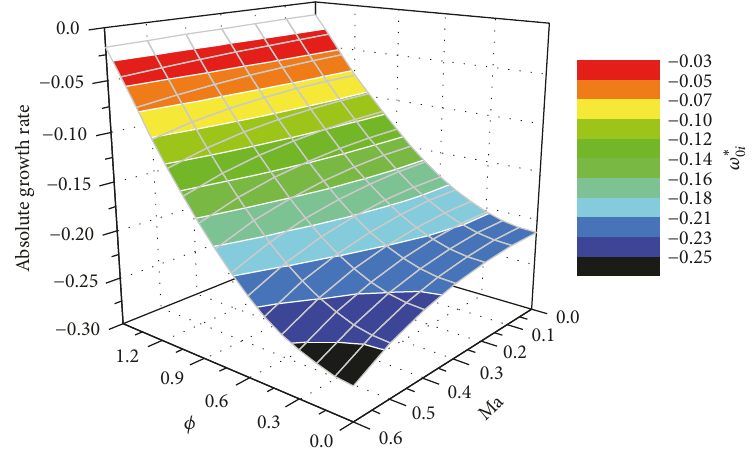
Figure 6: The variation of absolute growth rate with oblique angle and 𝑀 number ( Λ = 1 , 𝑆 𝑇 = 2 ).